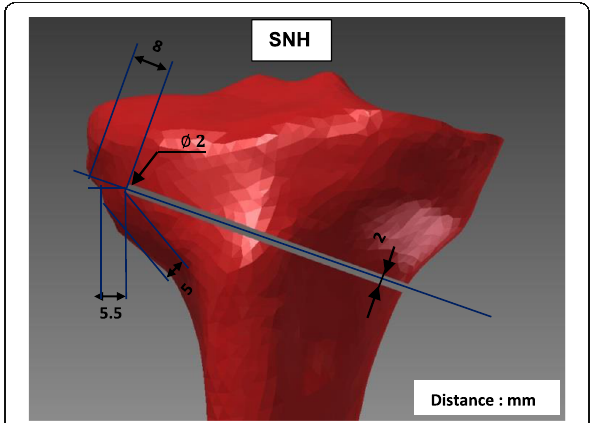
Fig. 1 Specimen SNH: This specimen has no hole at the lateral end of the osteotomy cut, which started on the medial side at 35 mm distally to the tibial plateau and finished 6 mm from the lateral cortex, 20 mm distally to the tibial plateau. The osteotomy cut had a thickness of 2 mm and the minimal thickness of the contralateral cortical bone was 5